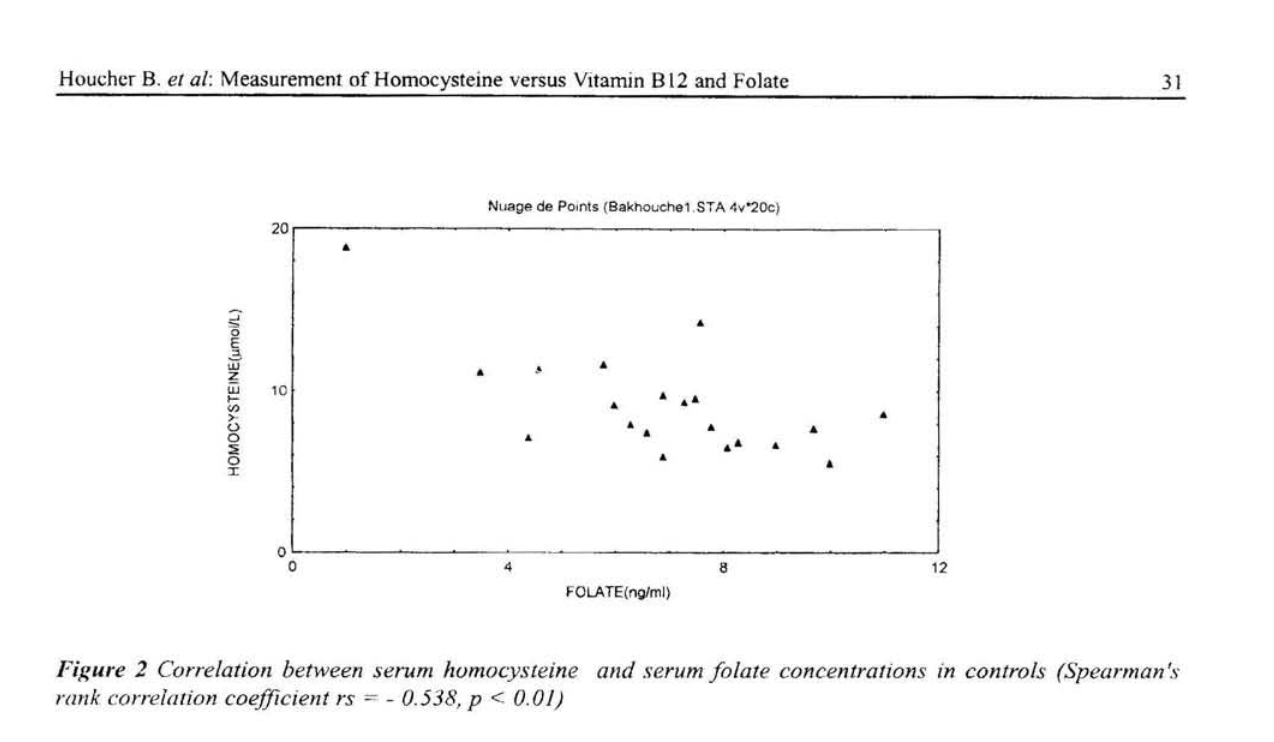
Figure 2 Correlation between serum humocysteine and serum folate concentrations in controls (Spearman 's rank correlation coefficient rs =• - 0.538, p < 0.01)